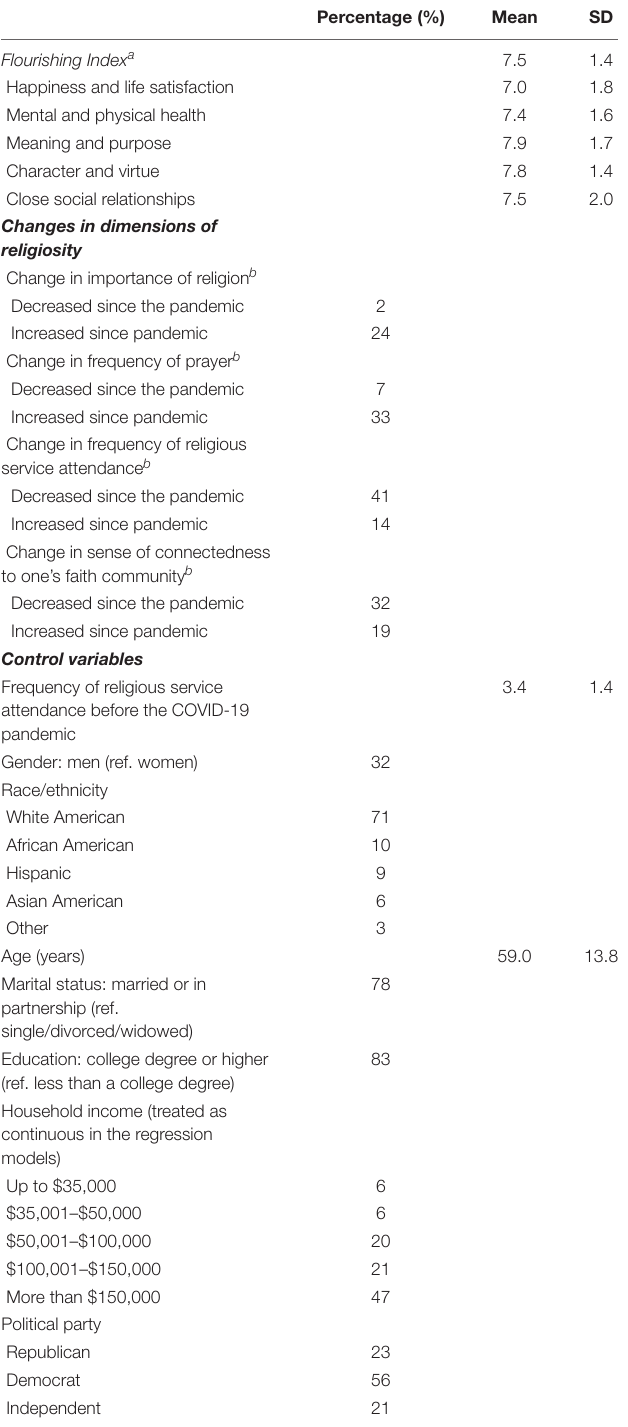
TABLE 1 | Descriptive statistics of the analytic sample ( N =